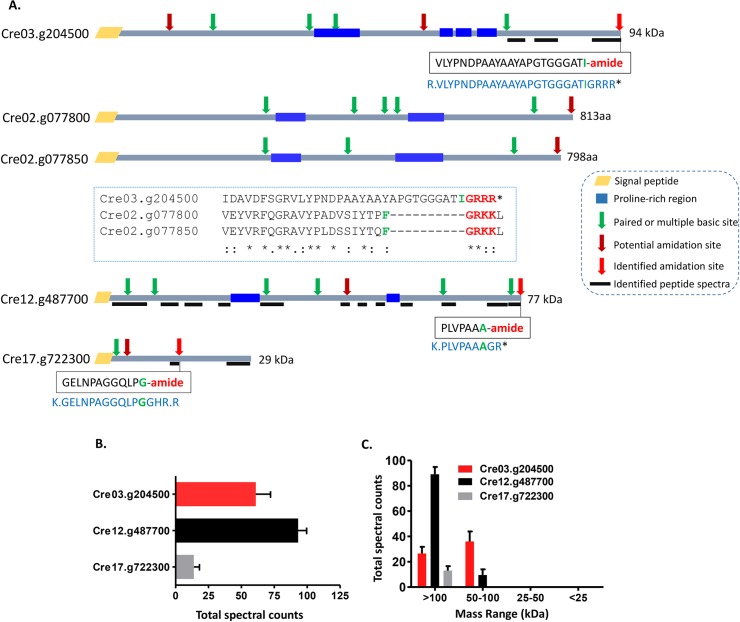
Identification of amidated products in mating ectosome-rich pellets.A. Sequences of the three amidated tryptic peptides identified are shown in boxes; the amidated residue identified is indicated in green. For each identified amidated tryptic peptide, a schematic diagram of the protein that could have generated it is shown; the sequence of each of these larger proteins (shown in blue) includes a cleavage site and a glycine residue. Thick black lines mark tryptic peptides that were identified throughout the proprotein. The domain organization and potential C-terminal amidation sites of Cre02.g077800 and Cre02.g077850, signal peptide–containing prepropeptide precursors (S7 Table) that resemble amidated protein precursor Cre03.g204500, are shown; neither of these potential amidated peptides was detected. B and C. Total spectral counts (n = 6; ± SEM) for the identified amidated protein precursors and the average number of spectral counts in gel slices encompassing proteins of different apparent molecular weight ranges are indicated. The underlying numeric data for this figure can be found in S1 Data. aa, amino acid.